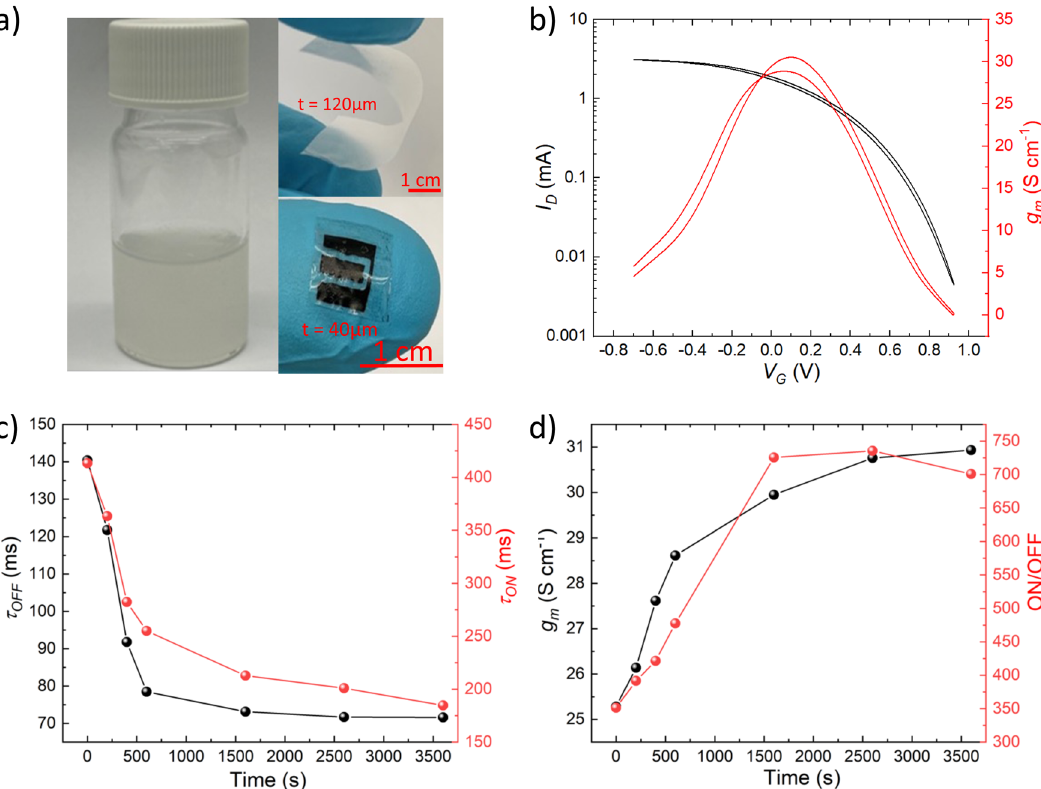
Fig. 3 Fully-3D-printed OECTs. a Photographs of the cellulose ink (left), printed fi lm (top right), and OECT (bottom right). b Transfer curve and normalized transconductance of the OECTs printed on cellulose substrate. c Evolution of the time response ( τ OFF and τ ON ) after biasing the gate at − 0.7 V for different times (up to 1 h in total). d Evolution of transconductance and ON/OFF ratio after biasing the gate at − 0.7 V for different times (up to 1